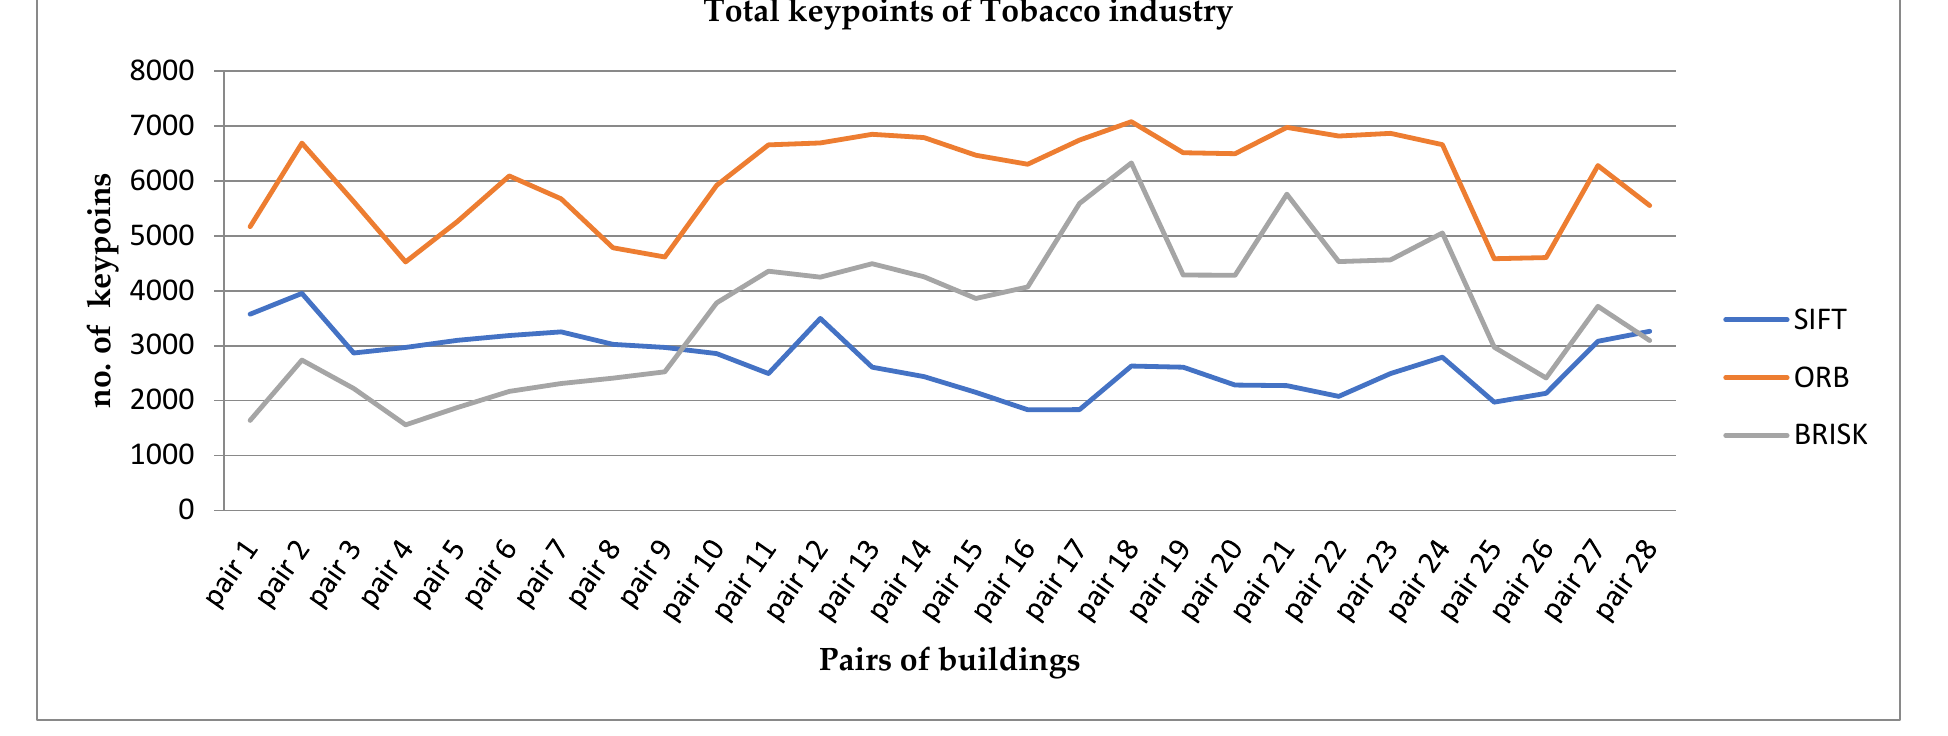
Figure 17. Total keypoints from each pair of images over time using modified parameters of algorithms.